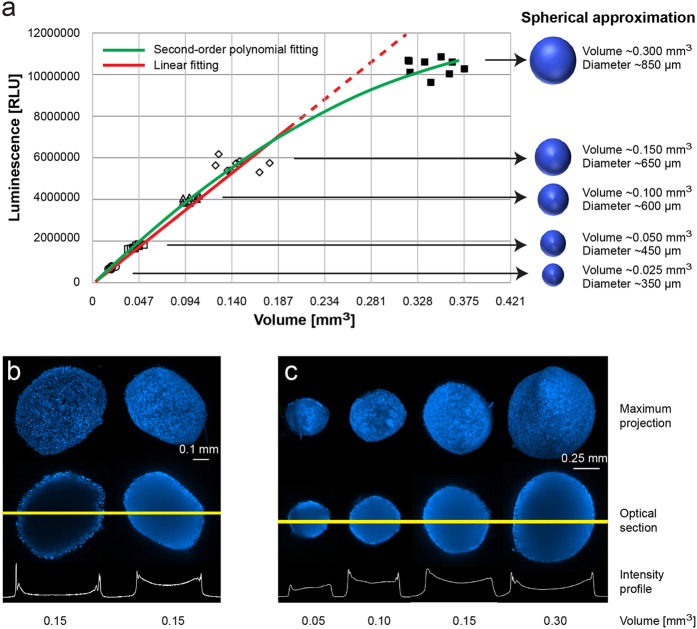
Validation of data obtained with CellTiter-Glo®3D Cell Viability assay in fibroblastic spheroids.(a) Spheroids were generated using the pellet culture system. The spheroids obtained were then subdivided into 5 volumetric categories: 0.025, 0.050, 0.100, 0.150, and 0.300 mm3, corresponding to an equivalent diameter of approximately 350, 450, 600, 650, and 850 μm. Using 9 homogeneous-shaped spheroids for each category, we performed the CellTiter-Glo®3D Cell Viability assay to investigate the relation between bioluminescence and volume. Bioluminescence increased in a linear manner up to a diameter of 650 μM (continuous red line). A significant deviance from linearity (green line) was observed for spheroids with a diameter of 850 μM. (b) Homogeneous-sized and -shaped MRC-5 spheroids were stained with Hoechst 33342 alone (left spheroids) or mixed with the CellTiter-Glo®3D reagent solution (right spheroids), as described in the Results section. Optical sections passing through the centre of the 3D structures and the corresponding maximum projections were captured with LSFM after 30 minutes. The fluorescence intensity profiles for the blue channel show a different degree of Hoechst 33342 penetration in the spheroid structures. Scale bar = 0.1 mm. (c) LSFM optical sections and fluorescence intensity profiles of spherical MRC-5 spheroids of increasing volume (left to right). The images show the complete penetration of Hoechst 33342 and CellTiter-Glo®3D reagent mixture in spheroids of up to 650 μm in diameter; Scale bar = 0.25 mm.